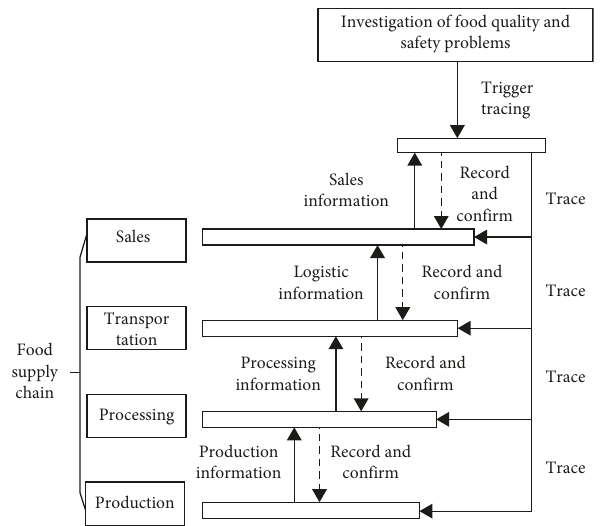
Figure 1: A diagram of the food quality source tracing